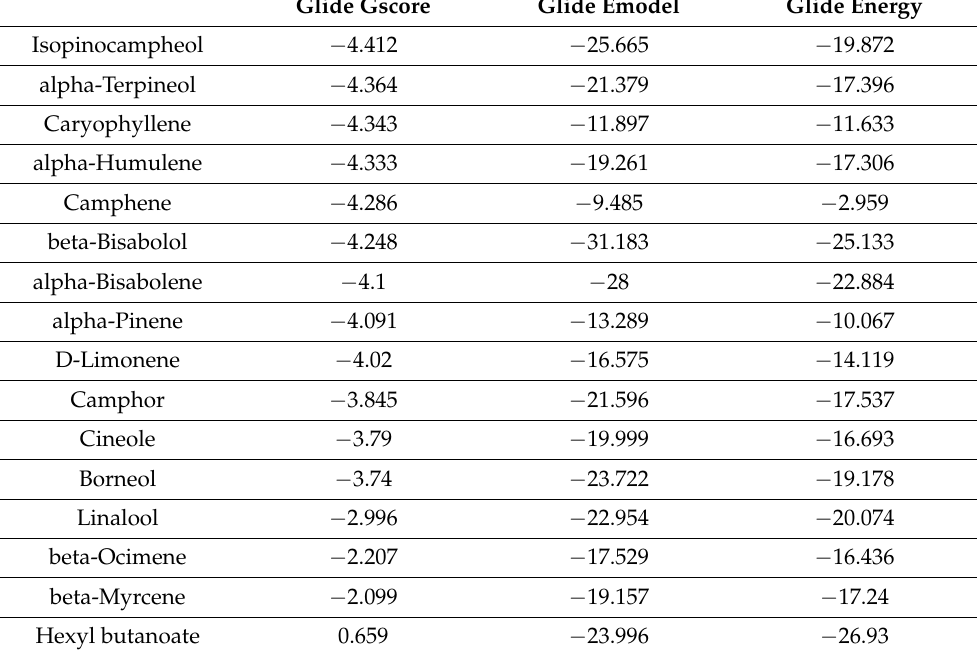
Figure 3. 2D diagrams of ligands interactions with the active site of NADPH. ( A ) Thujone; ( B ) o- Cymene; ( C ) Butanoic acid; ( D ) Gamma-terpinene.